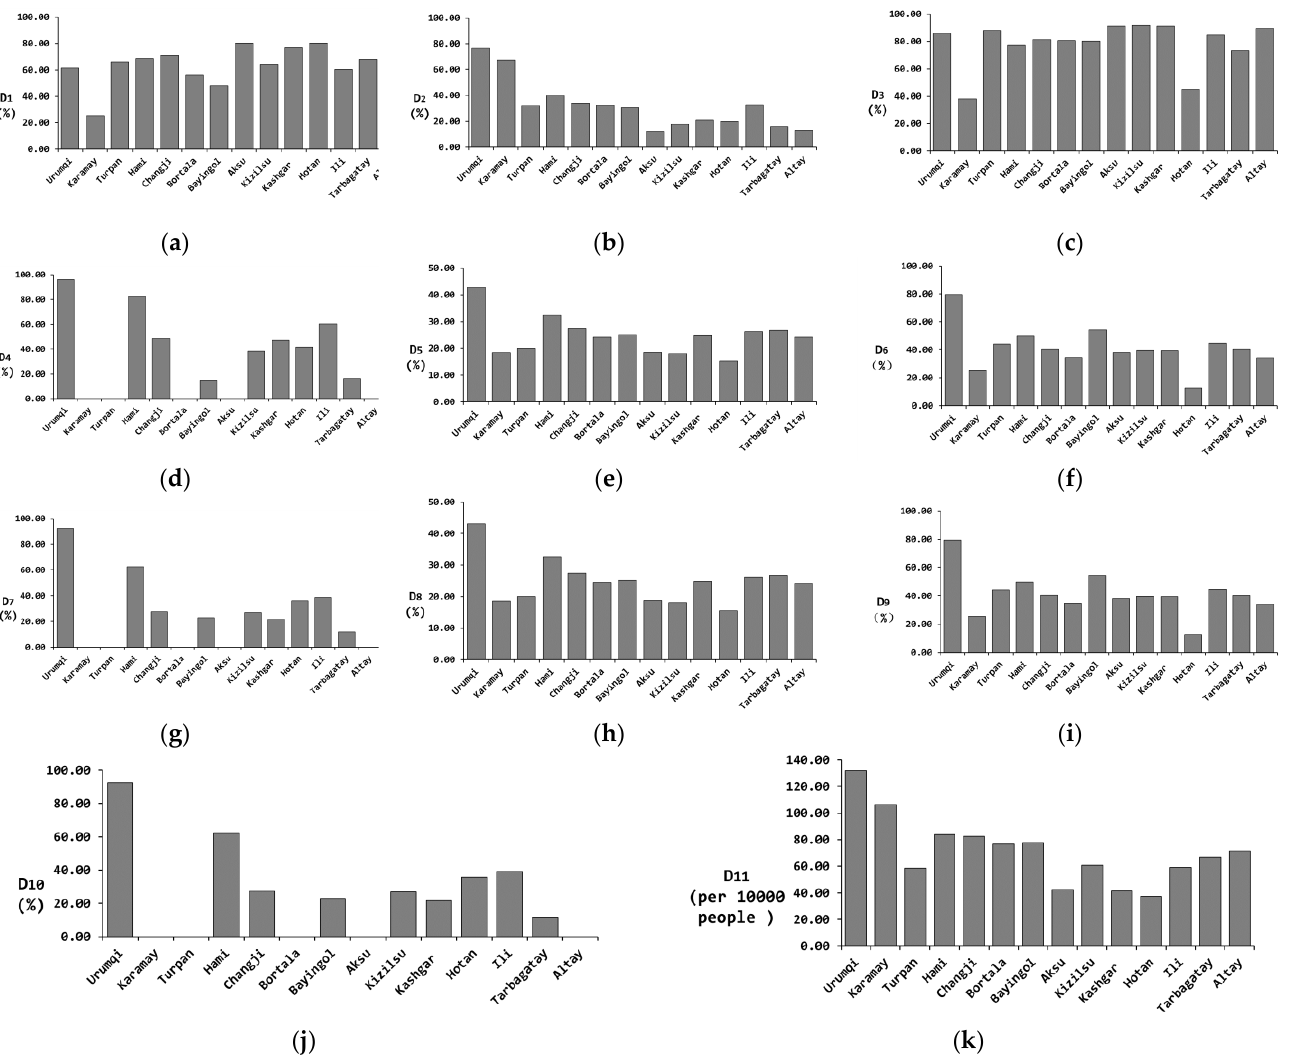
Figure 3. Histogram of indicator values for the allocation level of medical institutions in Xinjiang. ( a ) Indicator D 1 , ( b ) Indicator D 2 , ( c ) Indicator D 3 , ( d ) Indicator D 4 , ( e ) Indicator D 5 , ( f ) Indicator D 6 , ( g ) Indicator D 7 , ( h ) Indicator D 8 , ( i ) Indicator D 9 , ( j ) Indicator D 10 , ( k ) Indicator D 11 .